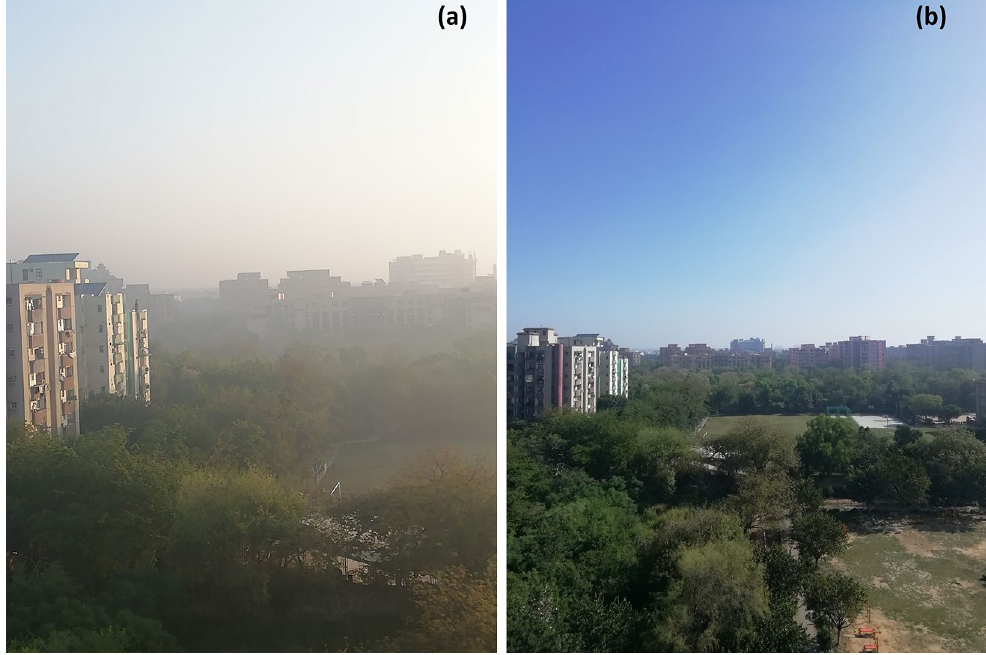
Figure 3. ( a ) A typical example of early morning haze at 0700 IST (left) and ( b ), clear sky at 1000 IST on 03 April 2020 (right). Sun rise was at 0610 IST. Haze disseminated within 3 h. Blue and clear sky conditions remained until 7–8 April 2020 and then bit dusty environment prevailed for 3rd week of April